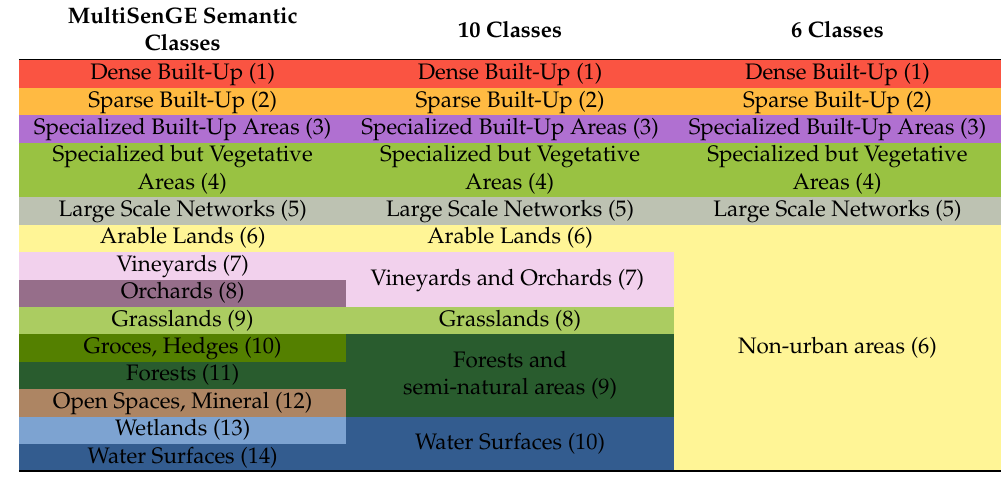
Table 3. Semantic classes for MultiSenGE dataset and our reclassification in 6 and 10